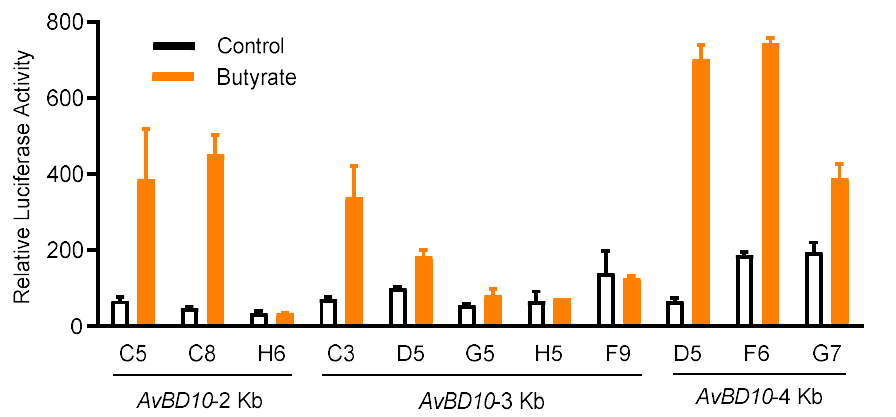
Figure 1. Relative luciferase activities of HTC/ AvBD10-luc stable cell clones in response to butyrate. Individual cell clones were integrated with a lentiviral luciferase reporter vector driven by AvBD10 gene promoter segments of approximately 2-, 3-, and 4-Kb. Each cell clone was stimulated in duplicate with or without 16 mM butyrate for 24 h. The luciferase activity was measured relative to the background luciferase activity of an equal volume of the cell culture medium, as an indication of AvBD10 gene activation. The results are means ± SEM of two independent experiments. ba ba